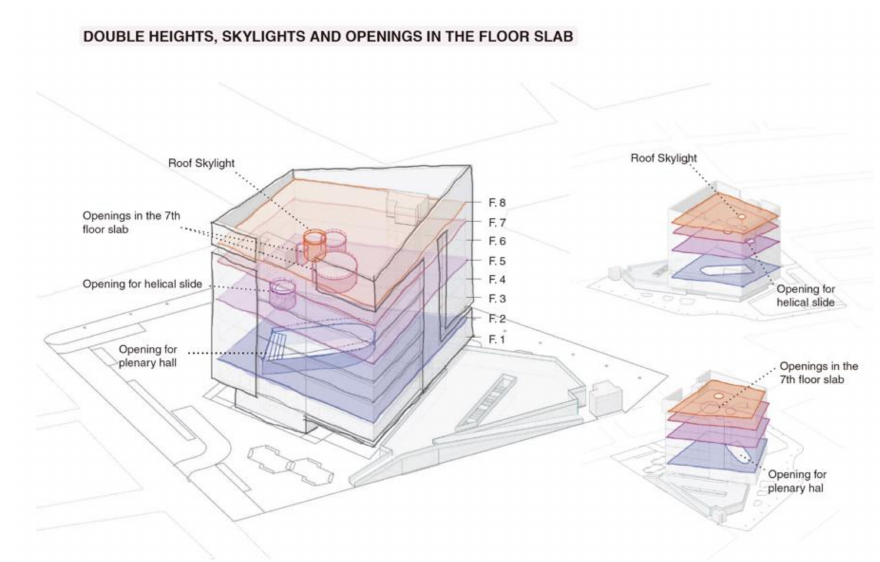
Figure 14. Volumetric diagrams of measures taken and actions relating to the following indicators: energy efficiency and green spaces; communications and relationship with the surroundings; shading; double heights, skylights and openings in the floor slab. Source: Created by the